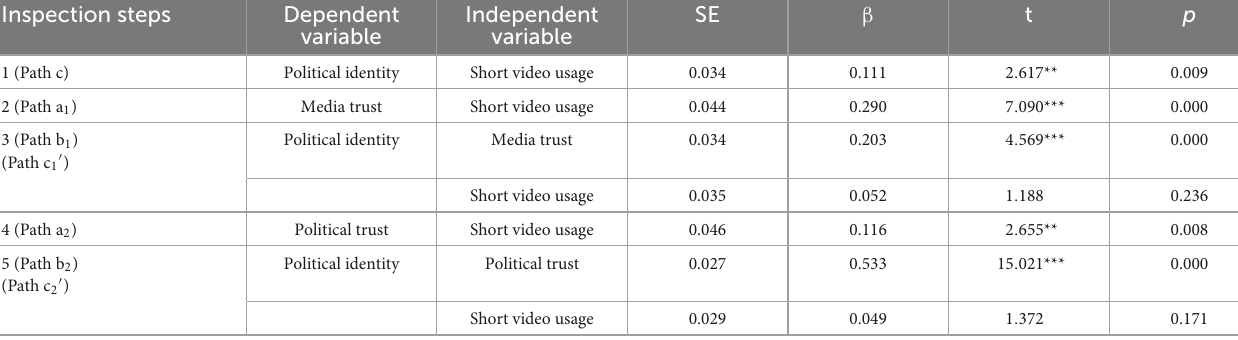
TABLE 4 The intermediary effect test of media trust and political